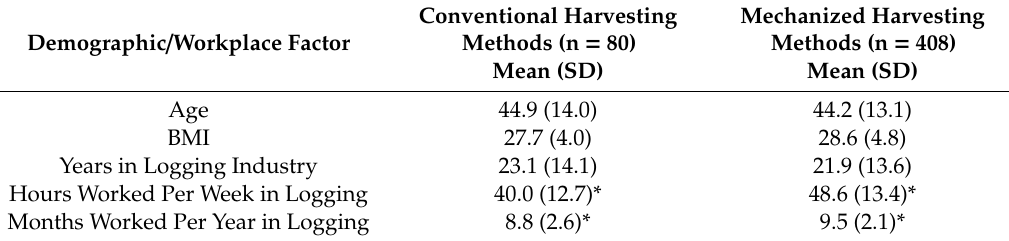
Table 2. The demographics by logging system